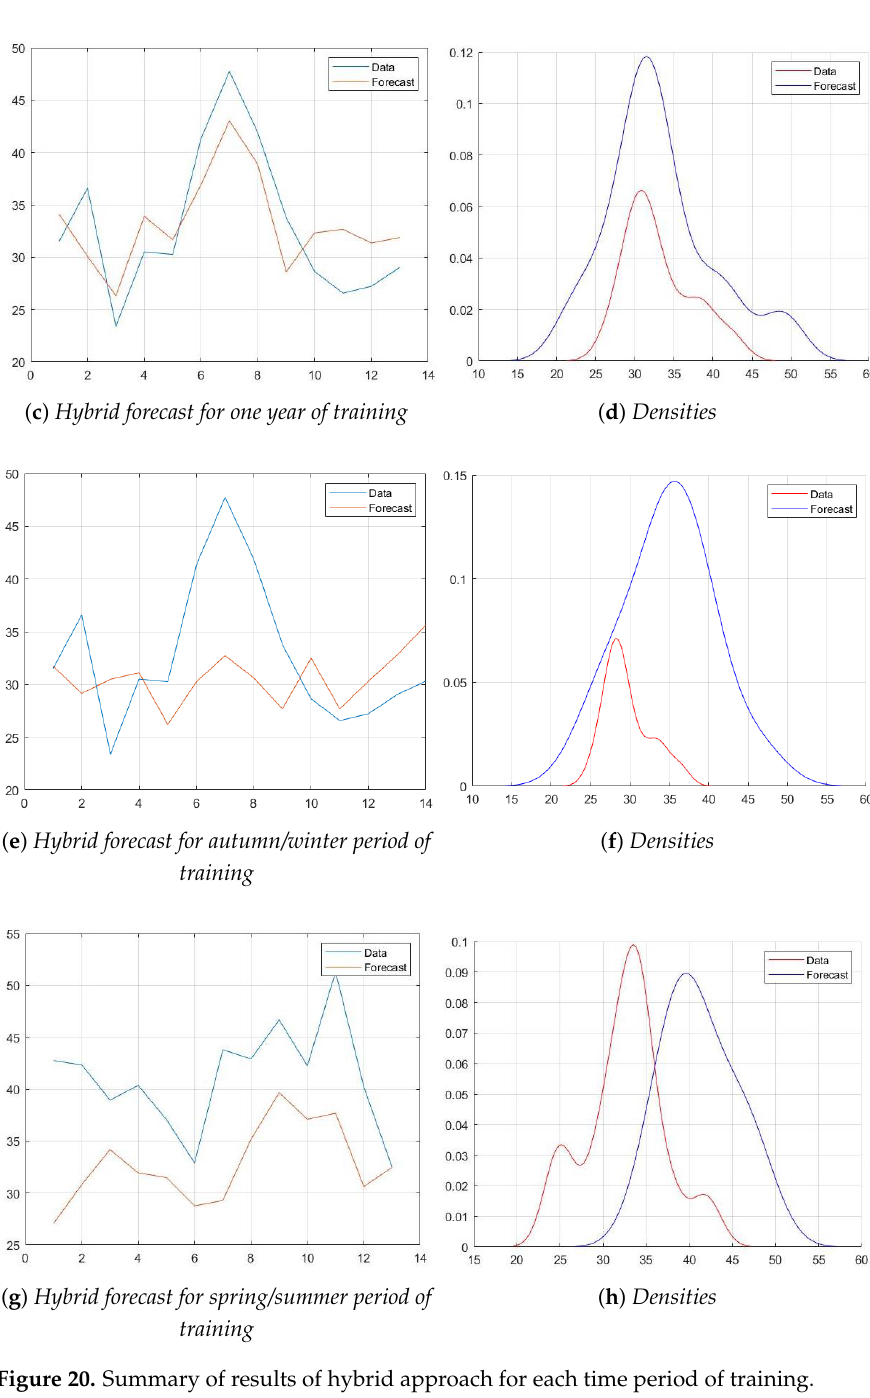
Figure 20. Summary of results of hybrid approach for each time period of